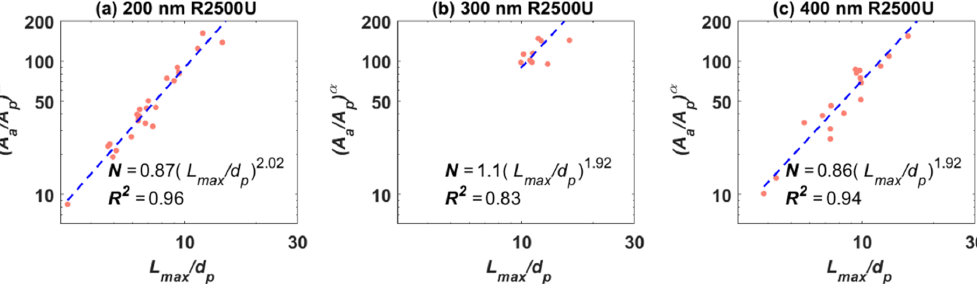
Figure A6. Power law fit to obtain 3-D fractal dimensions of (a) 200nm ( N = 25), (b) 300nm ( N = 12), and (c) 400nm ( N = 21) R2500U BC particles. More than 10 aggregates were analyzed for each size.